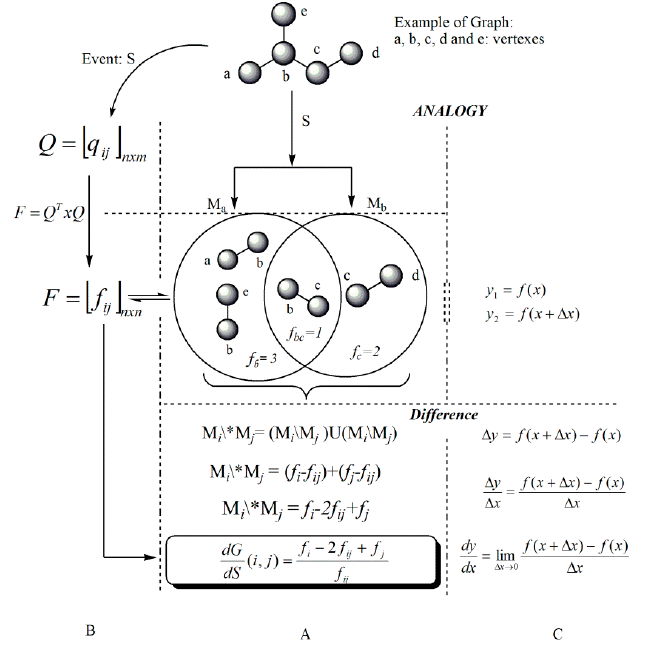
Figure 2. Scheme of the analogy between derivatives and their mathematical development. ( A ) Obtaining of the discrete derivative over a pair of elements i j from a graph G; ( B ) Algebraic development of the process for obtaining the discrete derivative over pairs of vertexes; ( C ) Obtaining of the classical derivative from the mathematical analysis.